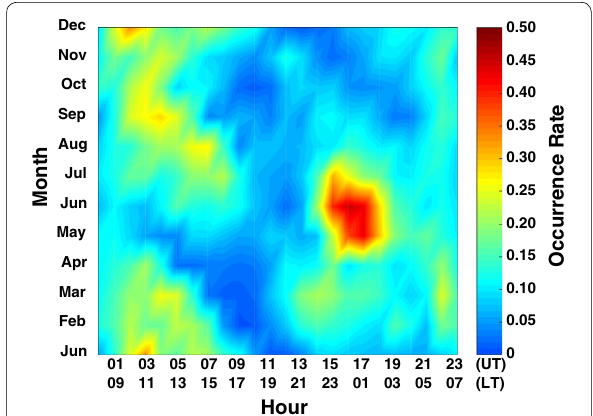
Fig. 3 LT and seasonal variations in MSTID occurrence rate in Hong Kong from 2014 to 2017